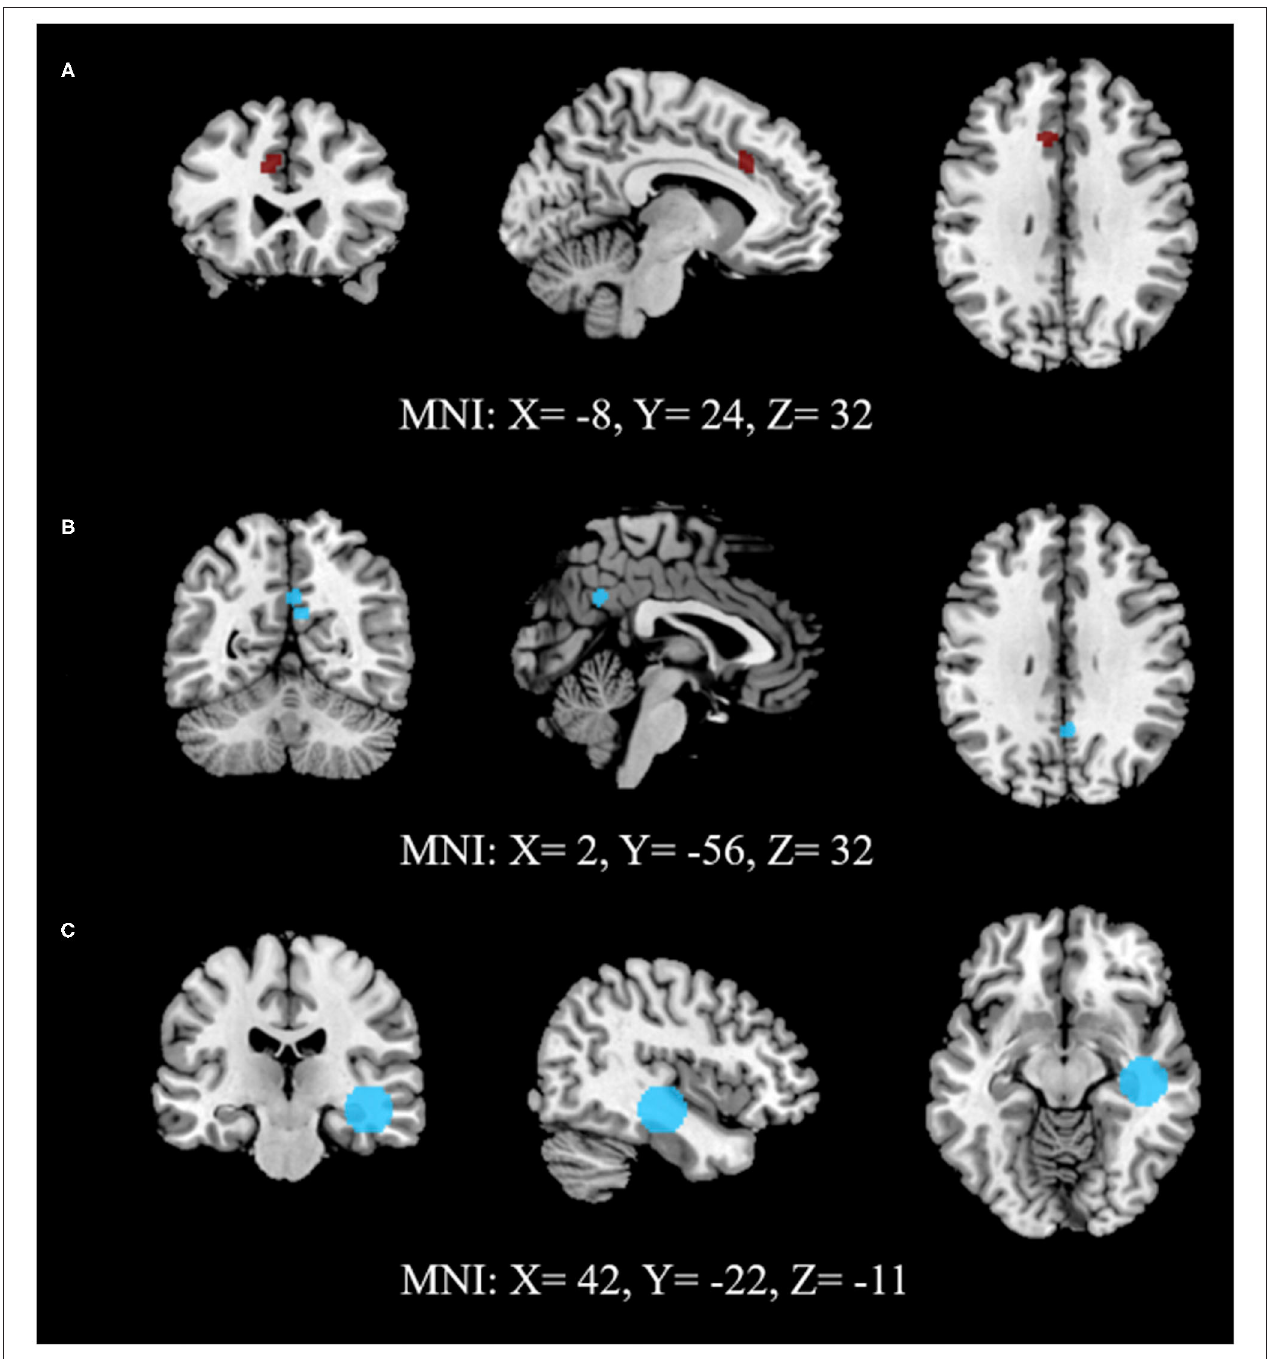
FIGURE 2 | Activation likelihood estimate results for studies measuring (A) ALFF, (B) network connectivity and (C) seed (RHC) to voxels to study the effect of ECT on rsFC. (A) shows lower (dark red) and (B,C) show higher (light blue) rsFC after ECT intervention. (A,C) use FWE (cluster-level extent thresholding) unlike (B) , which used FDR as correction for multiple comparisons during reporting significant changes between pre- and post-intervention (Refer to Table 3 for details).